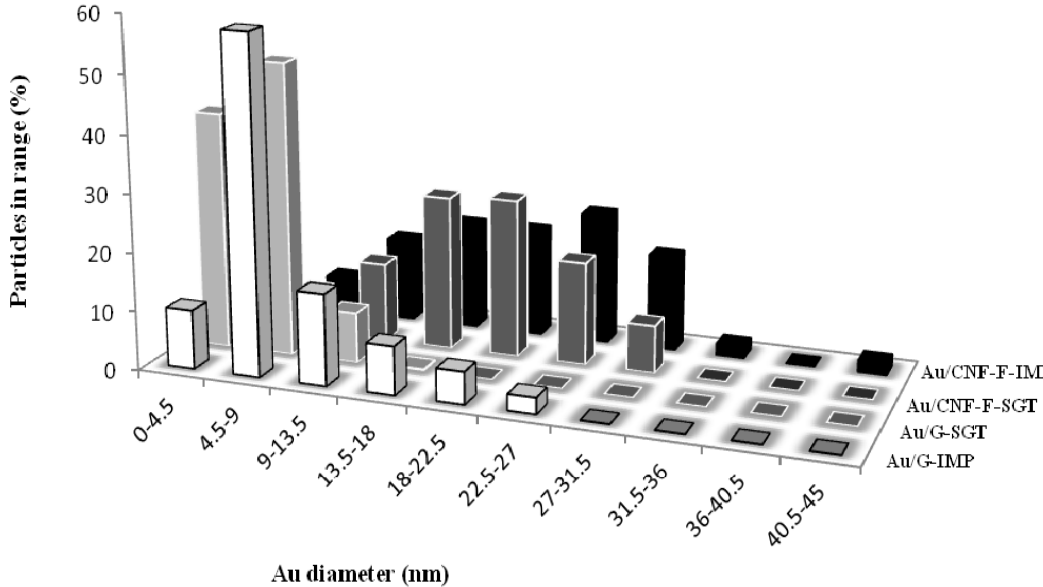
Figure 9. Gold particle size distributions associated to the activated catalysts synthesized by both the impregnation and the gold-sol